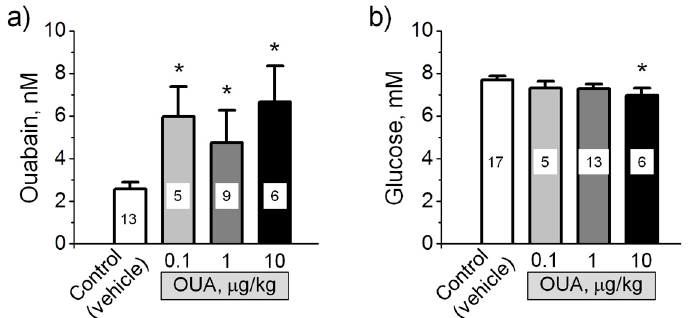
Figure 1. Serum ouabain level ( a ) and blood glucose level ( b ) of control rats and rats injected with different doses of ouabain (µg/kg, as indicated) for 4 days. The number of rats is indicated. * p < 0.05 compared with the corresponding control (vehicle treated group).